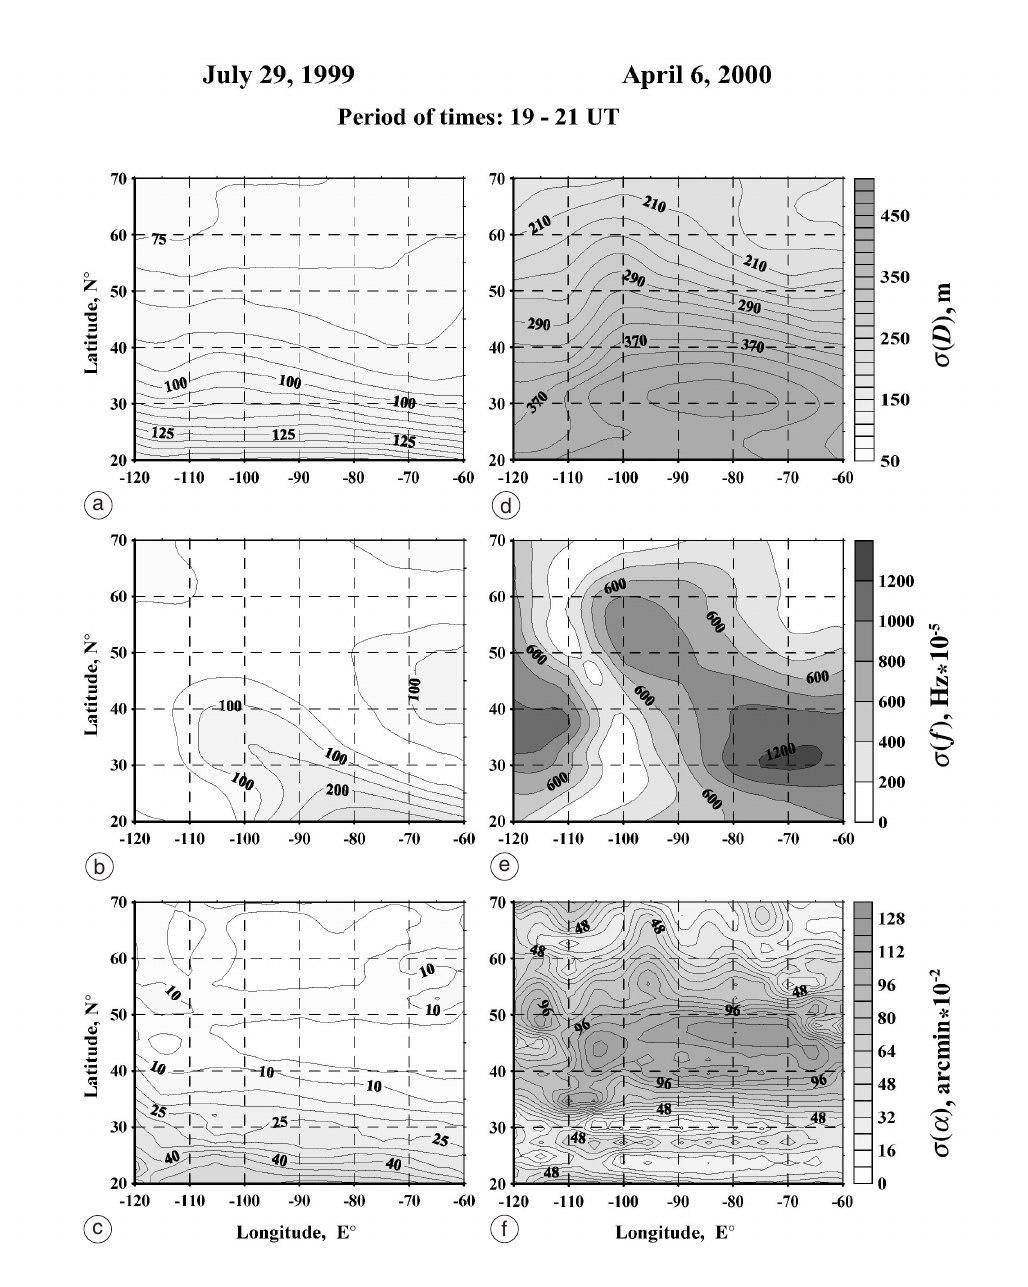
Fig. 3a-f. Maps of global distribution of measurement errors of the range σ ( D ), frequency Doppler shift σ ( f ), and of angles of arrival of radio waves σ ( α ) (panels a-c, for a magnetically quiet day; panels d-f, for a magnet- ically disturbed day). The errors can be evaluated from the graduated scale, shown in the figure at the